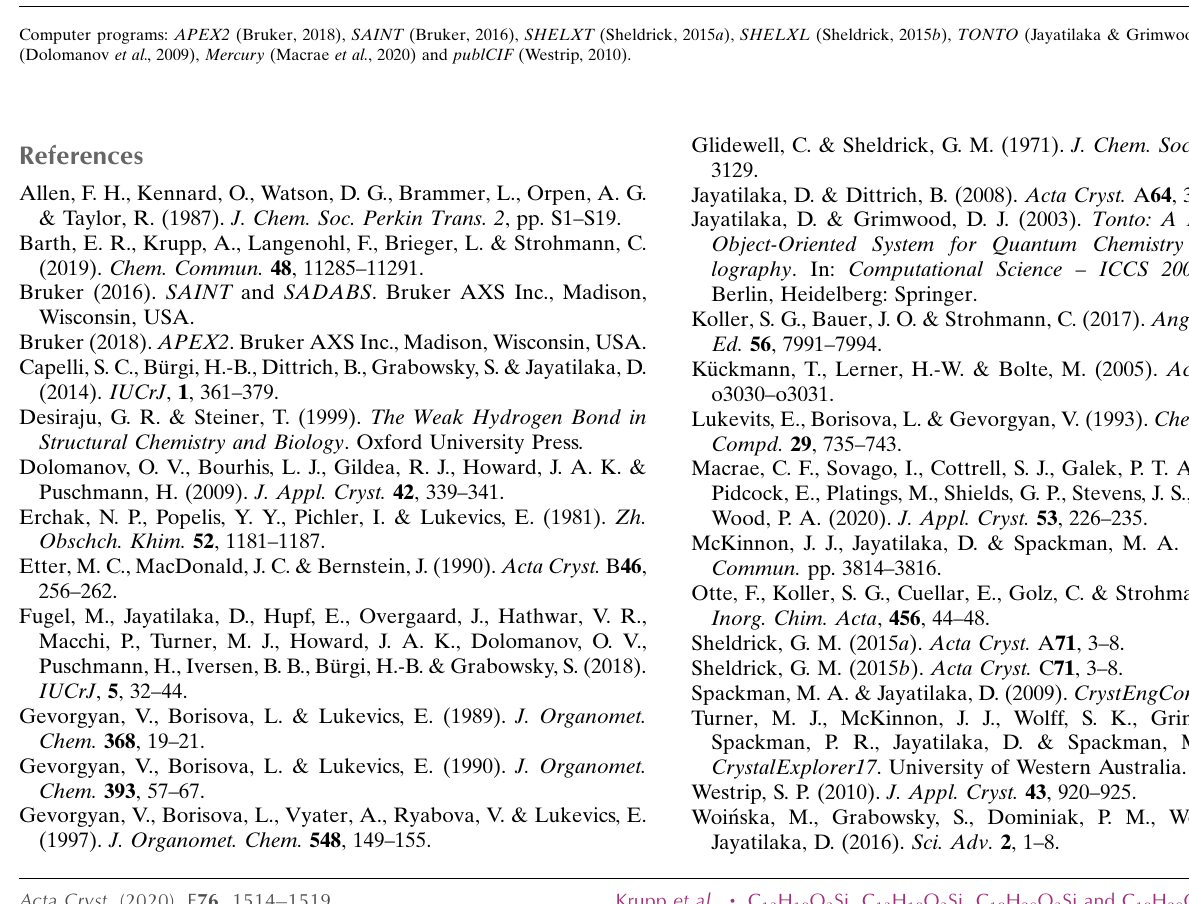
Crystal data Chemical